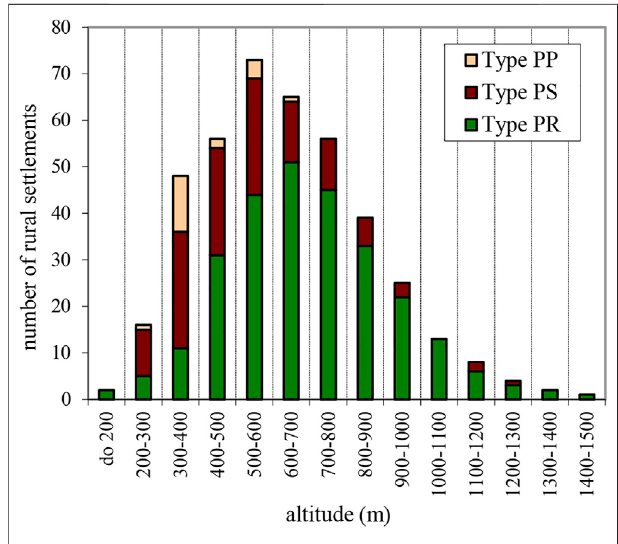
FIGURE 4 | Spatial differentiation of rural settlements according to altitude (The fi gure presents 21 settlements of Progressive type population change – Type P P , 119 settlements of Stagnant type of population change – Type P S and 269 settlements of Regressive type of population change – Type P R